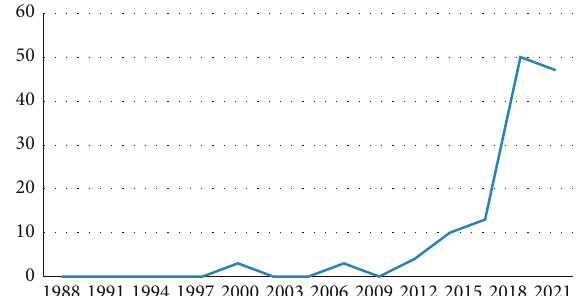
Figure 13: Article distribution by years for systematized review